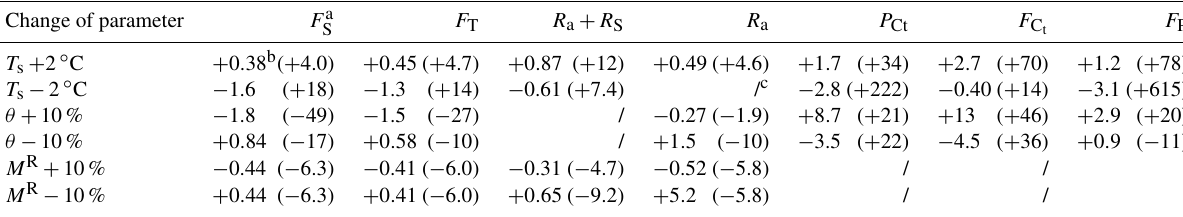
Table 5. Plant–interspace differences in the sensitivities of C fluxes to changes in soil temperature ( T s ), water content ( θ) and root biomass ( M R ) . Change of parameter F a